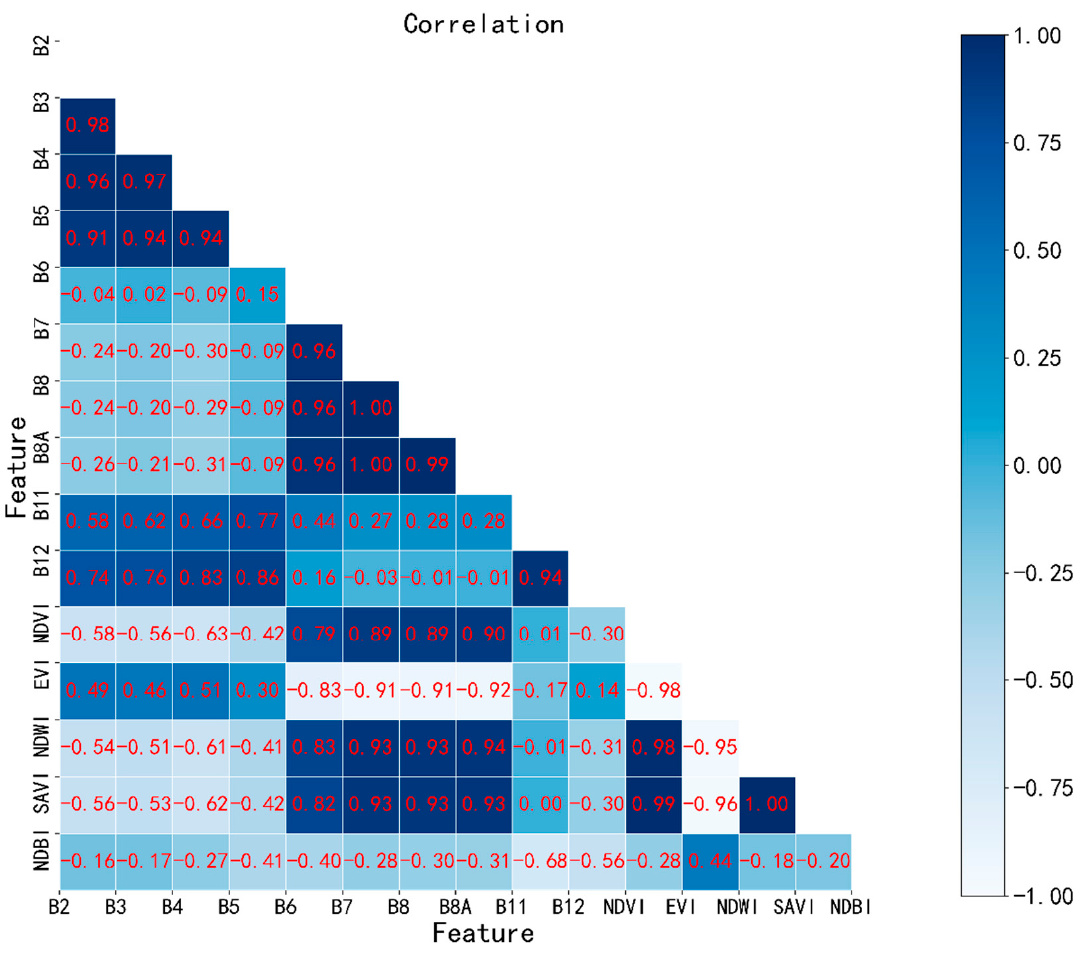
Figure 8. The output results of the Pearson correlation matrix.